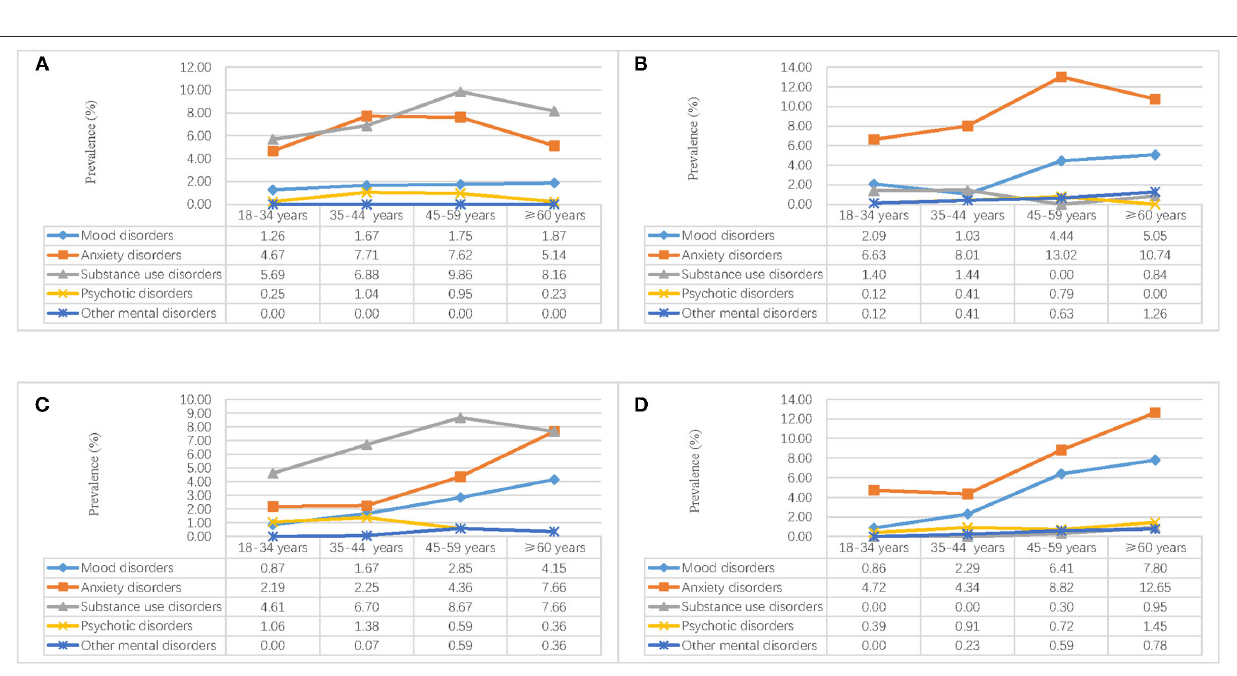
344 (1.65%) subjects met the diagnoses criteria for two, and 71 (0.34%) subjects met the diagnoses criteria for three or more for the1-month